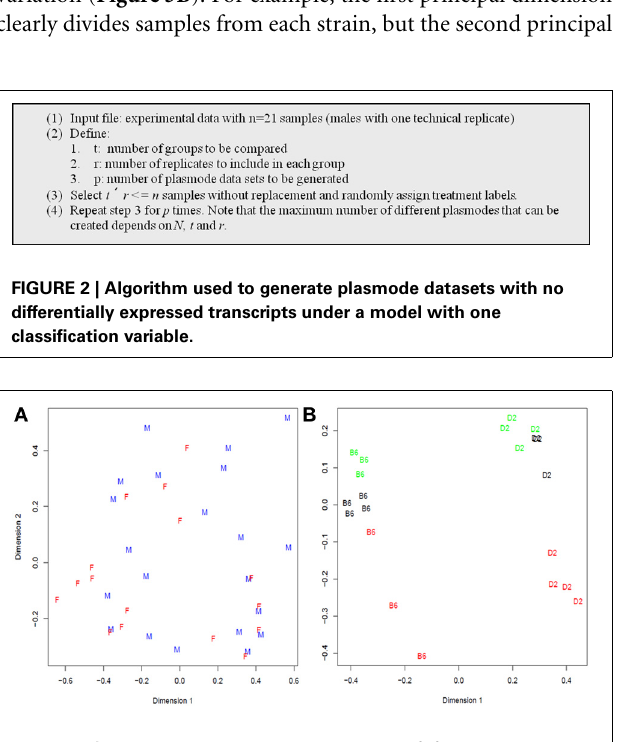
FIGURE 3 | Multidimensional scaling analysis of: (A) Cheung samples: F = Females and M = males; (B) Bottomly samples: labels correspond to strain (treatment) B6 = C57BL/6J, D2 = DBA/2J, and colors to flowcell number (block): red = 4, black = 6, and green = 7. In Cheung dataset there is not clear distinction between females and males while in Bottomly samples are first grouped in two large groups corresponding to strain B6 and D2 and then in subgroups consistent with flowcell